Question: Name the type of graph shown.
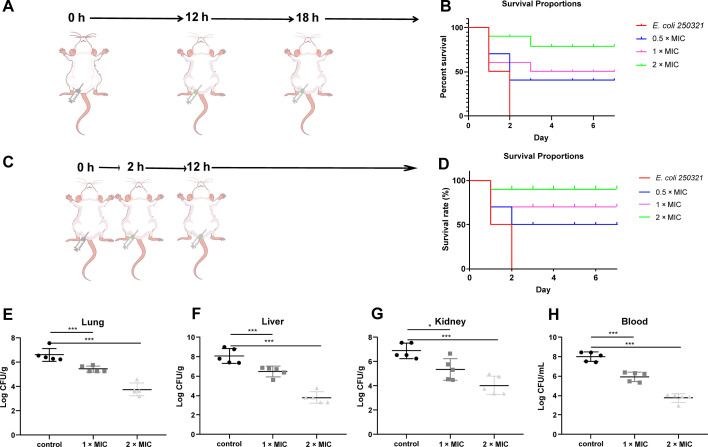
Answer: survival